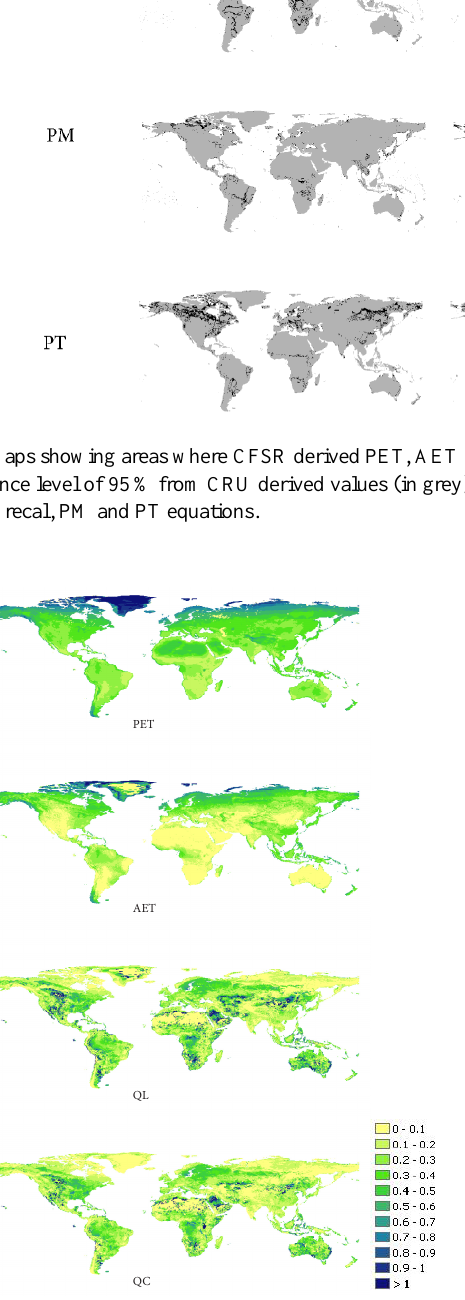
Fig. 9. Cell specific values of the coefficient of variation (CV; –) calculated from the six different potential evaporation methods for potential evaporation (PET), actual evapotranspiration (AET), local runoff (QL) and discharge